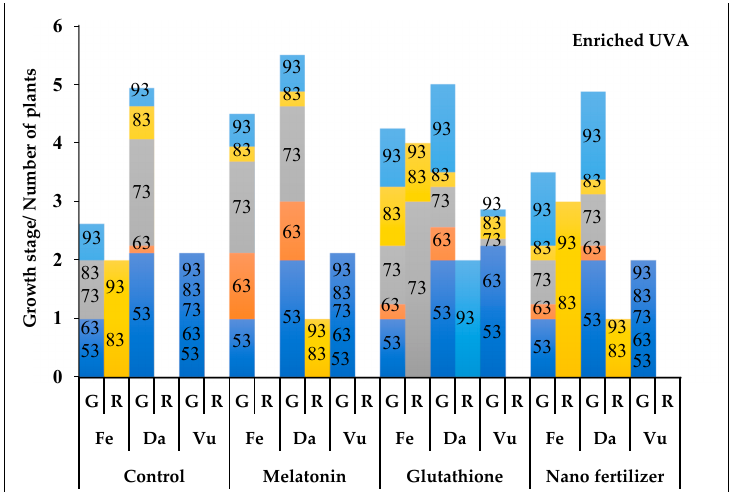
Figure 4. The phenological stages of Thymus fedtschenkoi (Fe), T. daenensis (Da) and T. vulgaris (Vu) under enriched UVA and following application of protectant compounds [water (control), melatonin, glutathione, iron-zinc nanofertilizer]. Both the rate of growth (G) and of rosette (R) are provided. Numbers on the columns represent days after pruning. For G column, the y-axis scale represents the following stages: 0–1, early vegetative stage (active growth or 4–6 leaf stage); 1–2, late vegetative stage (stem development); 2–3, budding stage (20% budding); 3–4, full budding stage; 4–5, early flowering stage; and 5–6, full flowering stage. For R column, the y-axis scale represents the number (out of 4) of rosette plants.